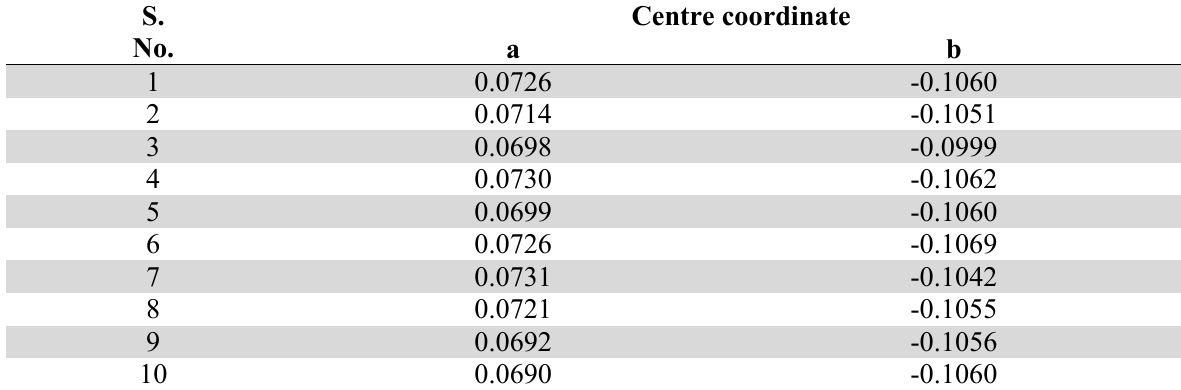
Centre co-ordinates of least square circle from profile centre S.